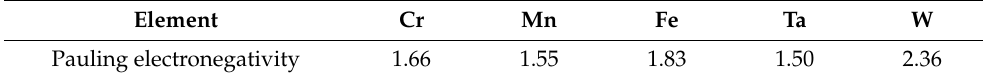
Table 2. Pauling electronegativity of each element in Cr 20 Mn 17 Fe 18 Ta 23 W 22 . Element